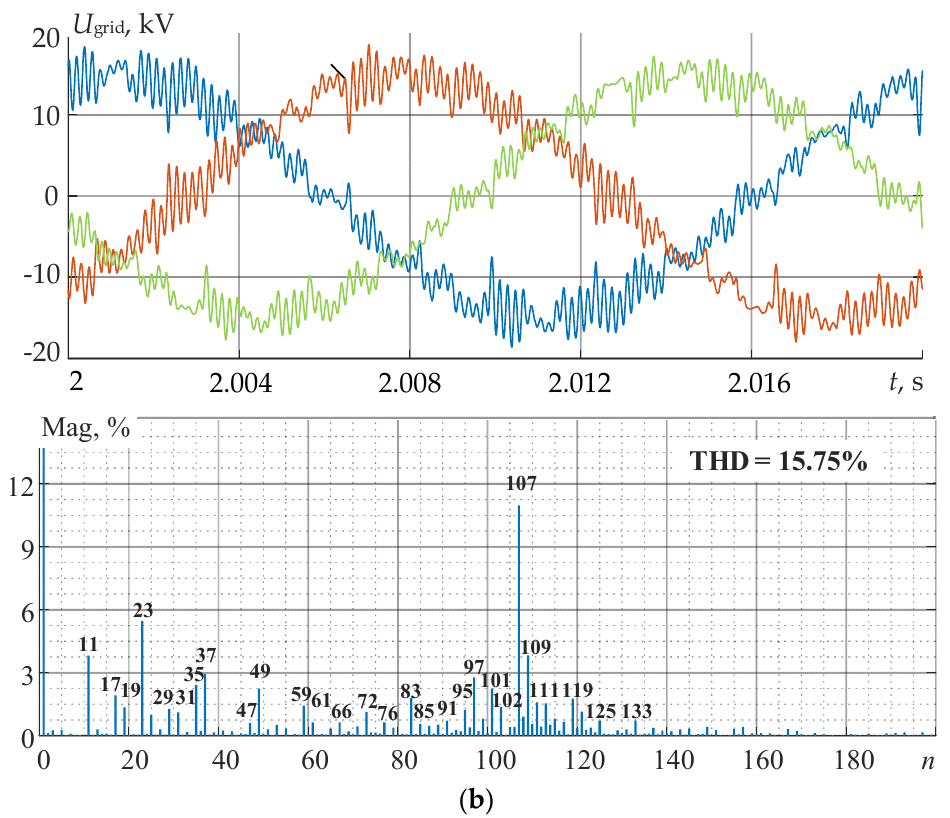
Figure 3. Results of experimental studies confirming the electromagnetic compatibility problems of powerful electric drives at insufficient grid power: ( a ) the AFE drive is switched off; ( b ) the AFE drive is switched on.